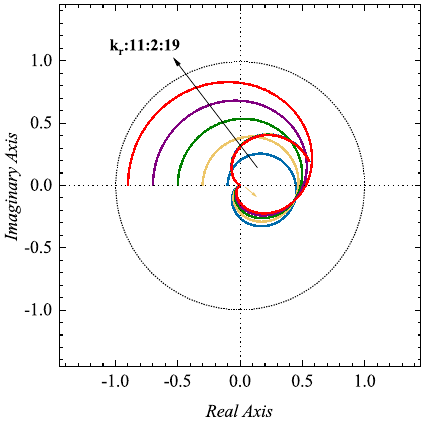
Figure 11. Nyquist curves of the T ( z ) when k r